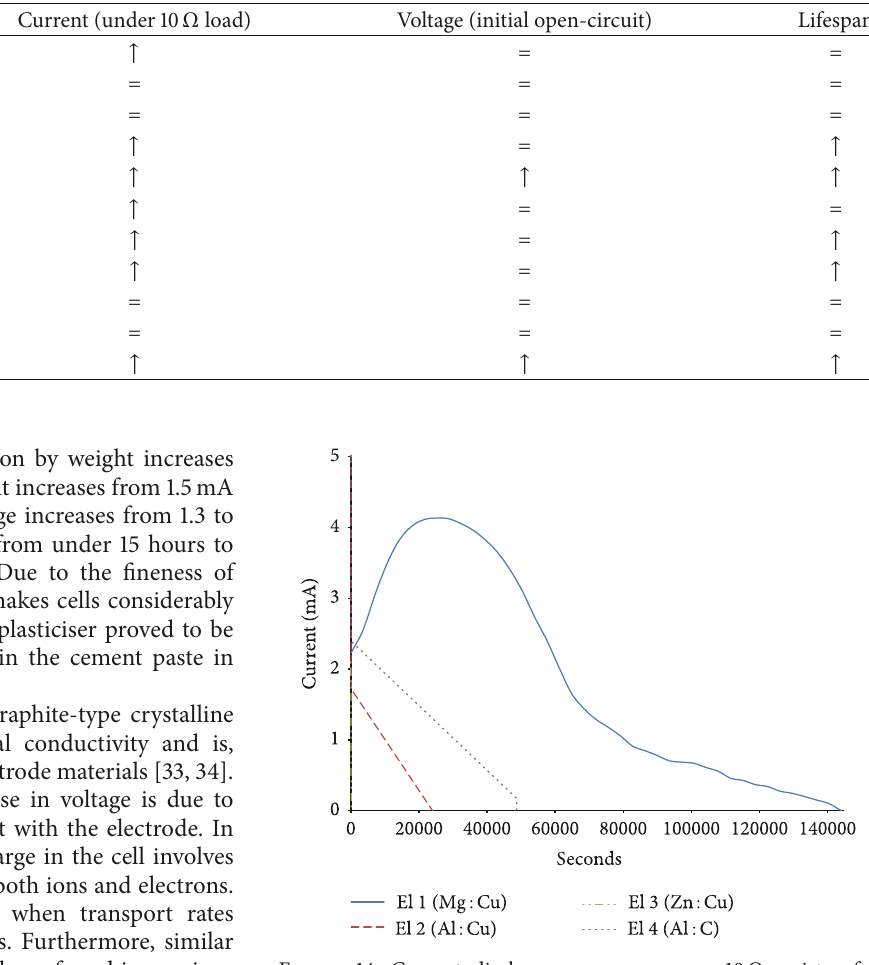
Figure 14: Current discharge curves across a 10 Ω resistor for different electrode combinations (note: this is not a logarithmic